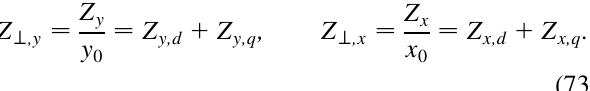
(1), G (2), and G 1 2